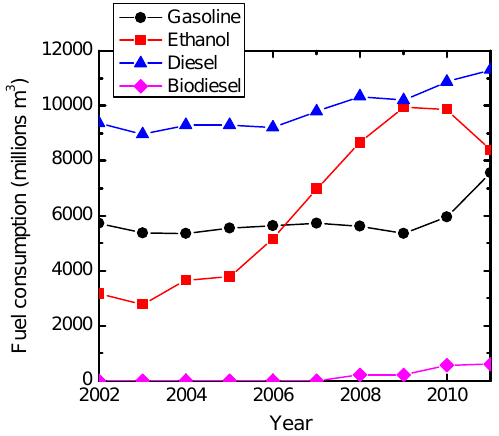
Fig. 1. Fuel consumption in the São Paulo state. Data from the Brazilian National Agency of Petroleum, Natural Gas and Biofuels. The indicated ethanol is the sum of anhydrous (part of gasohol) and hydrous (E100). The biodiesel consumption was calculated consid- ering its minimum content in diesel: 2% in 2008–2009 and 5%